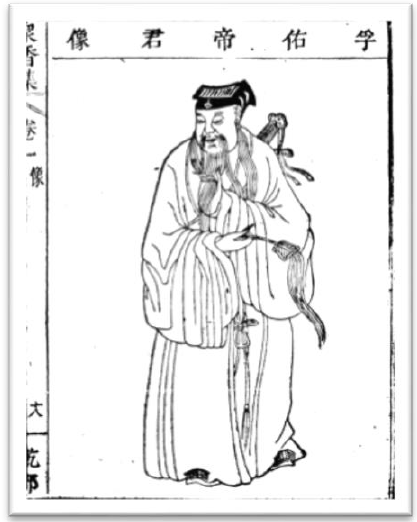
Figure 7. Thearch of Succour [Patriarch Lü] ( Collection of Various Fragrance [CHJ] 1881).